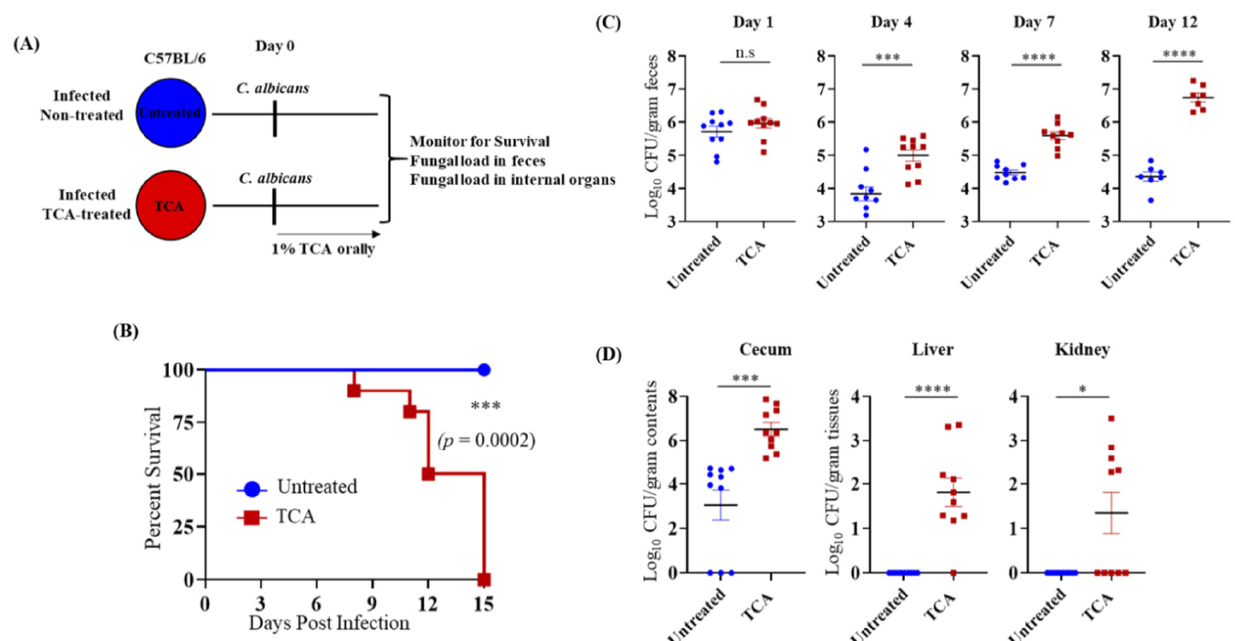
Figure 2. TCA alone induces fungal colonization and dissemination in the absence of antibiotics and immunosuppression. ( A ) Experimental outline. C57BL/6 mice infected with ~2 × 10 8 CFU CA SC5314 via oral gavage. Untreated mice received sterile drinking water (untreated group); the treatment group received sterile water containing 1% TCA (TCA group). ( B ) Mice were monitored for survival. A log-rank test was performed using 95% confidence intervals; statistical significance was calculated to compare the antibiotic-treated and untreated control groups. ( C ) Fungal load from feces collected from untreated and TCA groups 1-, 4-, 7-, and 12-days post-infection. ( D ) Fungal load from cecum, liver, and kidney from dead mice was collected immediately in the TCA-treated groups and mice euthanized 15 days post-infection for untreated groups. Ten mice per group were used, and the data represent mean ± SEM. Statistical significance was evaluated using the Mann–Whitney U test. p values ≤ 0.05 (*), ≤ 0.001 (***), ≤ 0.0001 (****) were considered statistically significant.